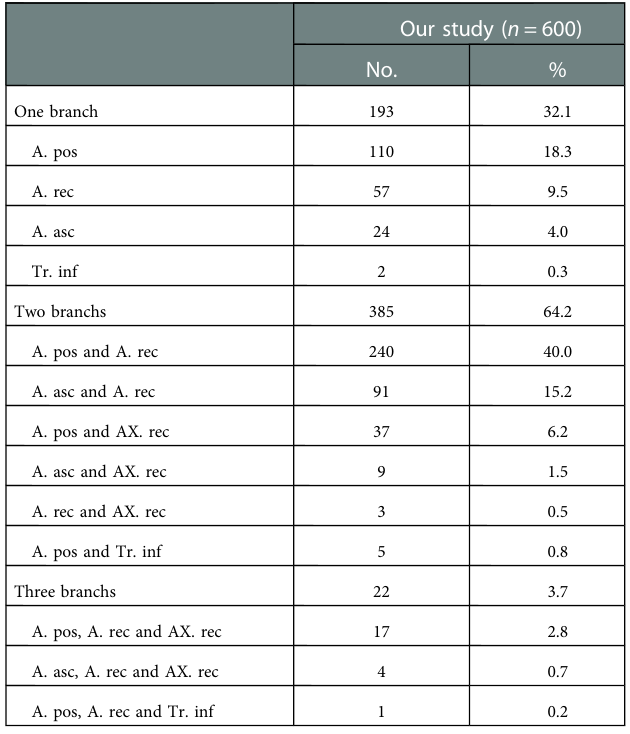
TABLE 3 Distribution of AX.rec in bronchus